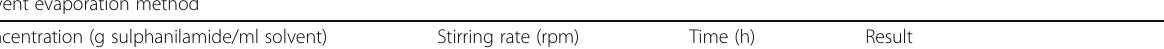
Table 1 Summary of the results